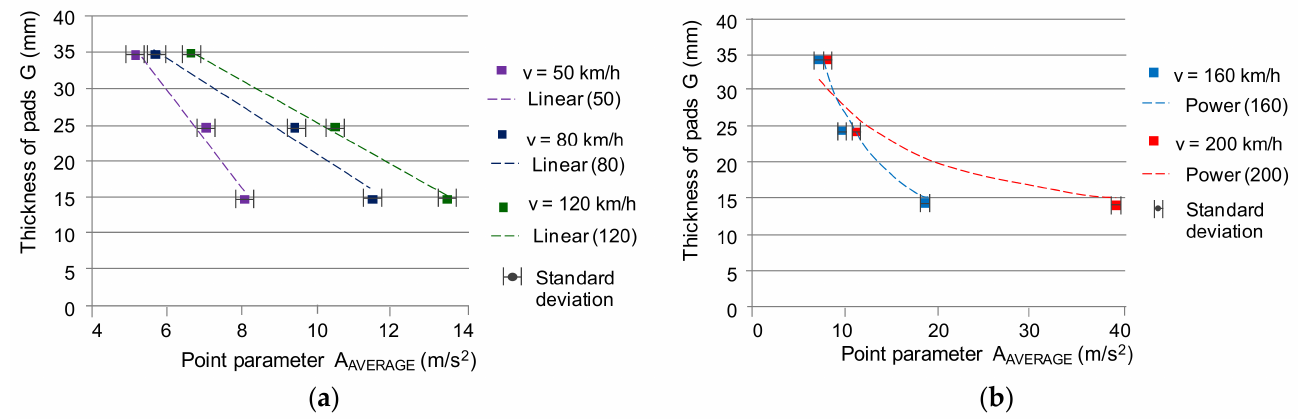
Figure 9. Dependence of the friction lining thickness on the effective value of vibration acceleration for the braking speed: ( a ) v = 50, 80 and 120 km/h, ( b ) v = 160 and 200